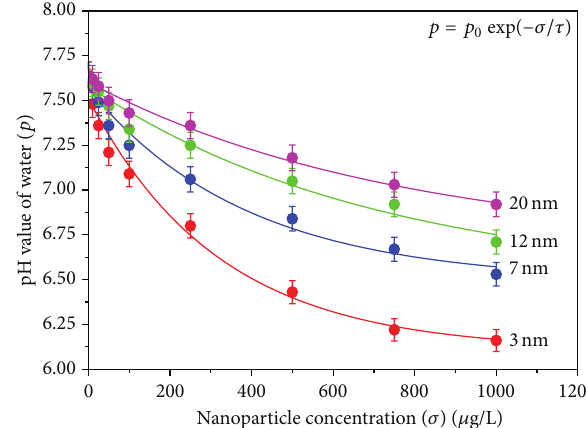
Figure 1: Variation of dissolved oxygen content ( 𝐷 O to exposure of ZnS nanoparticles of different sizes with increasing nanoparticle concentration ( 𝜎 ) for a fixed exposure time ( 𝑡 = 6 days).